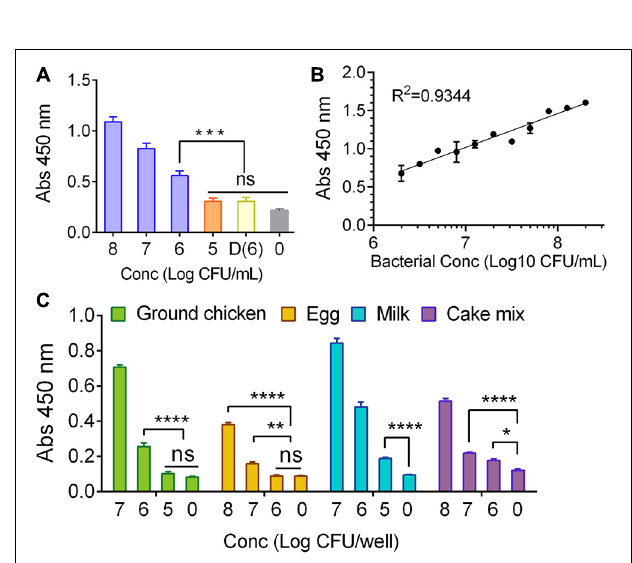
FIGURE 2 | Mammalian cell-based immunoassay specificity. MaCIA reaction with 15 Salmonella Enteritidis strains (SE), 12 non-SE and 7 non- Salmonella bacteria (A) , with viable and dead S . Enteritidis serovars (B) , to viable S. Enteritidis in the presence of the equivalent amount of dead S. Enteritidis (C) , and S . Enteritidis PT21 in the presence of other bacteria (Lm, L. monocytogenes F4244; Ec, E. coli EDL933 and Pa, Pseudomonas aeruginosa PRI99). L: live SE; D: Dead SE (D) . Confocal image and Giemsa staining analyses of adhesion of live (Live SE) and dead (Dead SE) S . Enteritidis PT21 to formalin-fixed HCT-8 cells; (E) Z-stack of the scanned images, (F) total bacterial counts per five fields for confocal images. Blue: nucleus, green: S . Enteritidis, (G) Giemsa stained images showing adhesion of live (Live SE) but not dead (Dead SE) S . Enteritidis PT21 to formalin-fixed HCT-8 cells. Rod-shaped dark blue, S. Enteritidis (arrows); purple, nucleus; Bar graph showing bacterial counts per field from five fields. Error bars represent SEM. **** P < 0.0001; ** P < 0.01; ns, no significance. Cut-off for positive: P < 0.001. Scale bar = 5 µ m.